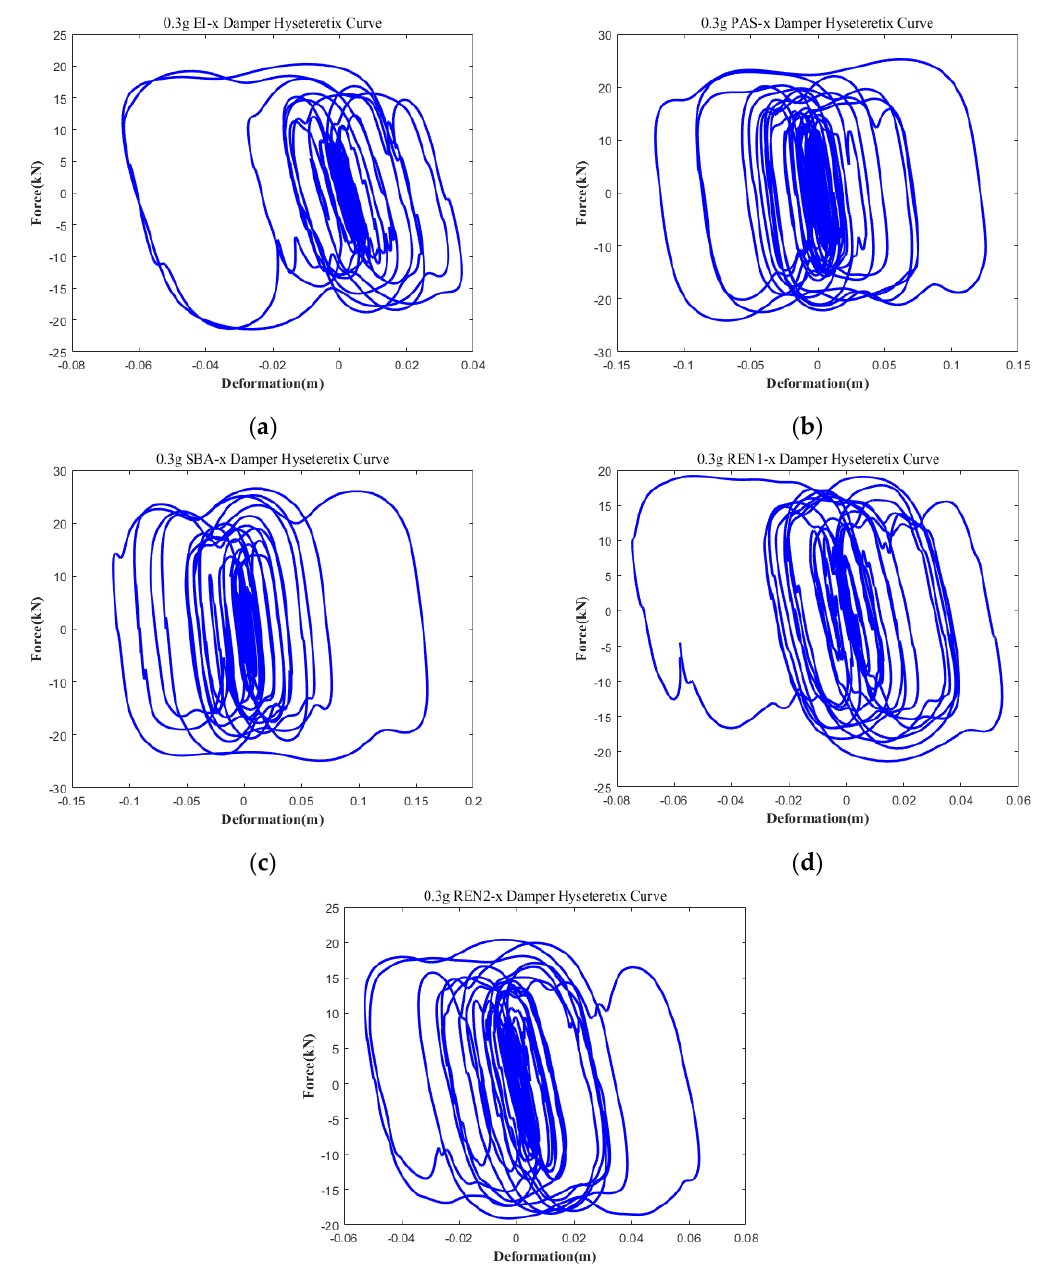
Figure 26. Hysteretic curves of viscous dampers under different earthquake waves at a peak of 0.3 g. ( a ) Hysteresis loops under EL seismic wave at peak of 0.3 g. ( b ) Hysteresis loops under PAS seismic wave at peak of 0.3 g. ( c ) Hysteresis loops under SBA seismic wave at peak of 0.3 g. ( d ) Hysteresis loops under REN1 seismic wave at peak of 0.3 g. ( e ) Hysteresis loops under REN2 seismic wave at peak of 0.3 g.